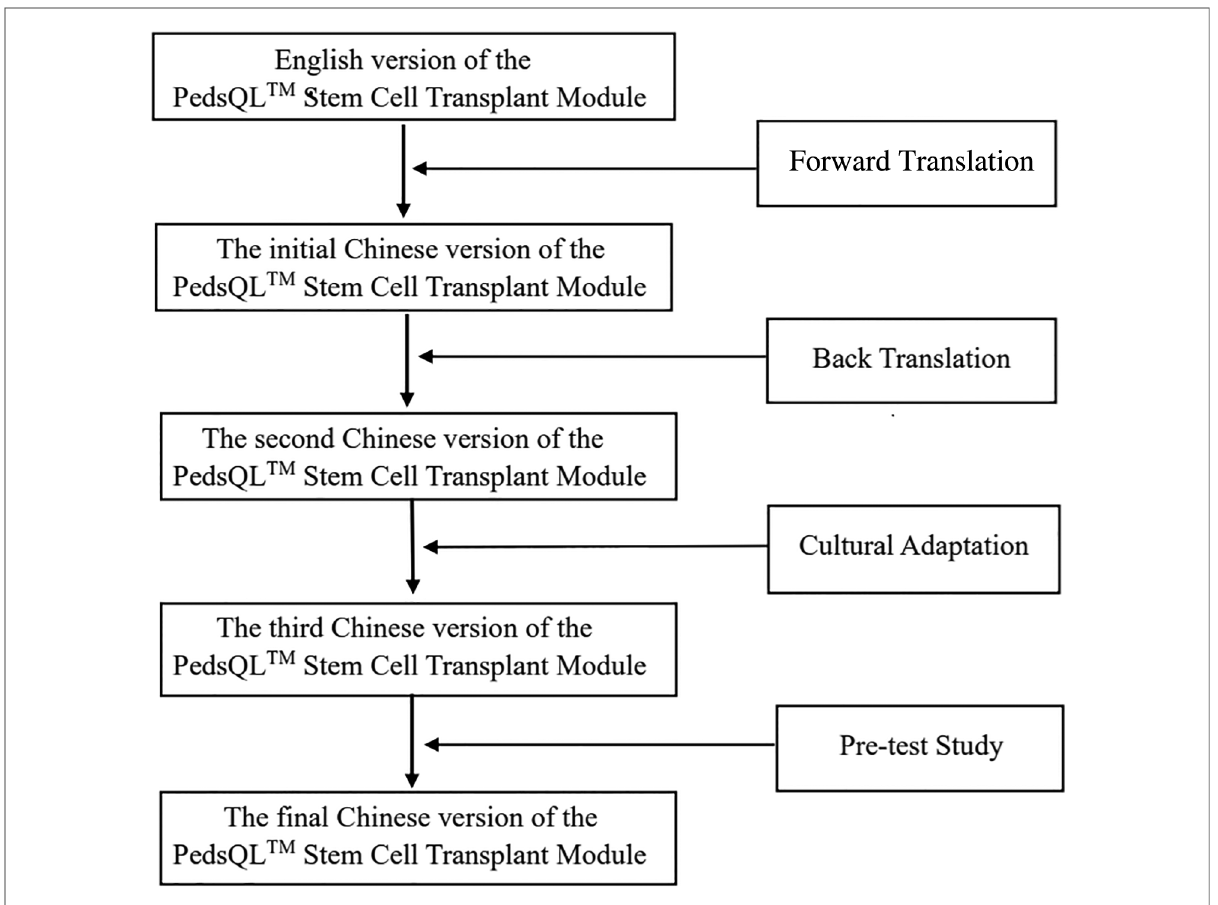
FIGURE 1 The translation procedure of the PedsQL ™ stem cell transplant